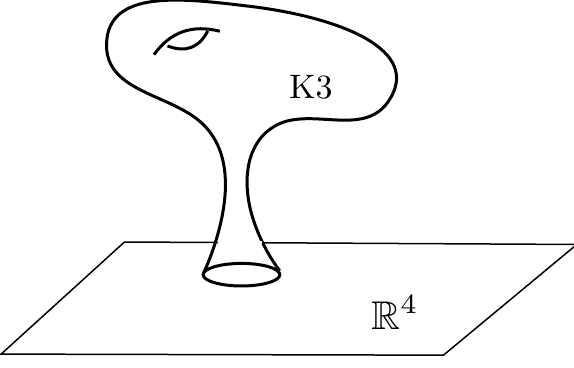
(cid:0) (cid:1) charge on via the connected sum R 2 R 4 via a small R 4